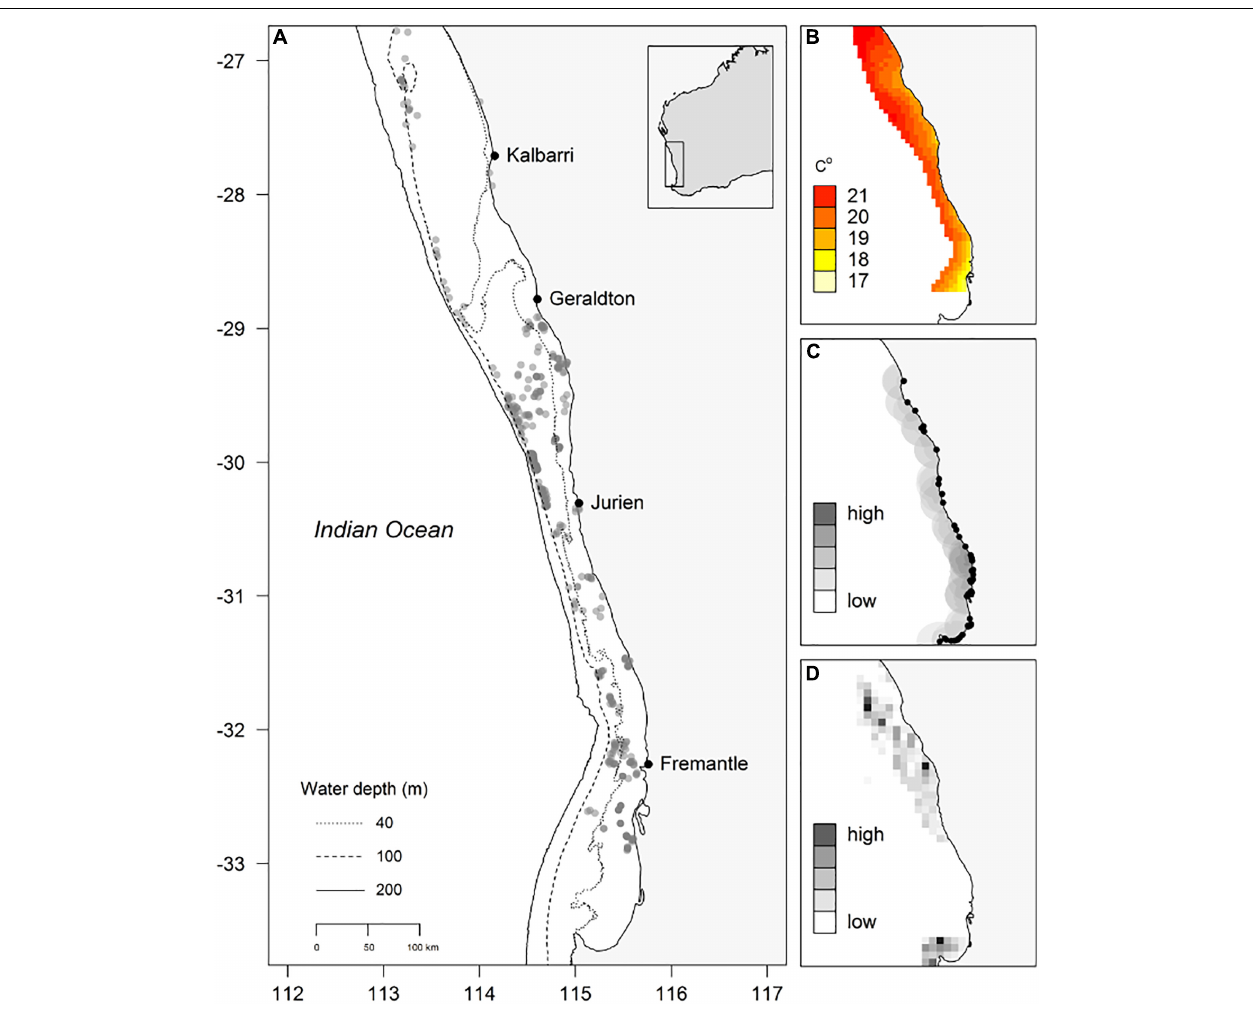
FIGURE 1 | (A) Locations of deployment of POTBots (gray dots), (B) modeled winter ocean bottom temperature, (C) the recreational fishing index (grayscale, 0.01 degree cell size) and location of boat ramps (black dots), (D) the normalized commercial catch data (grayscale, 0.167 degree [10 min] cell size).